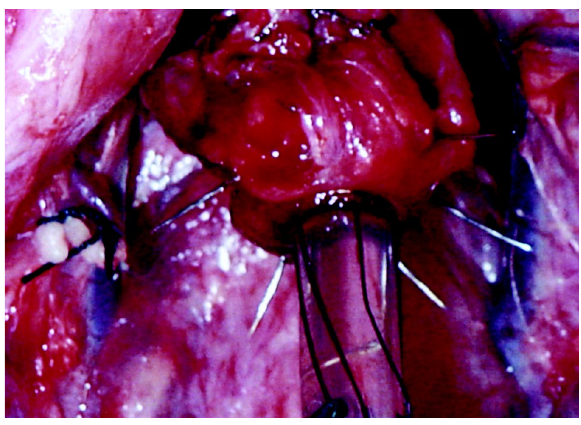
Figure 5 – Piston with open needles inside the urethral lumen. Figure 6 – Exteriorization of all needles after piston